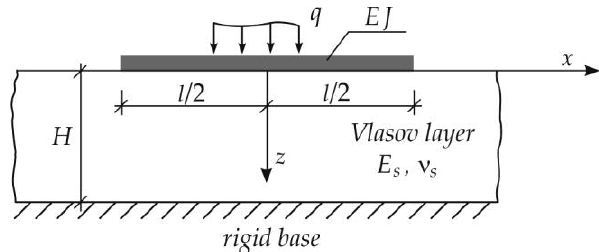
Figure 2. Beam on the Vlasov soil model.